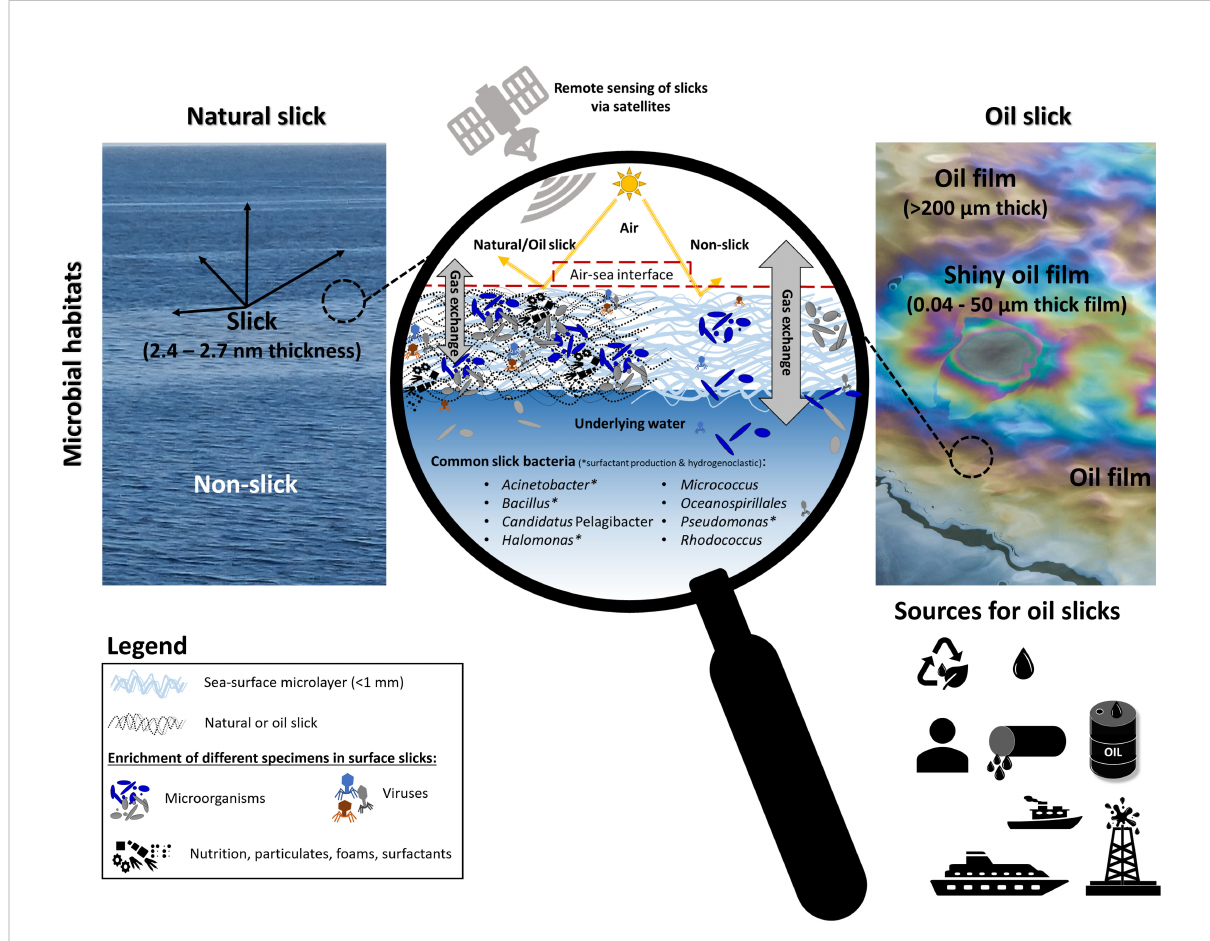
FIGURE 1 Concept of natural surface slicks (left) and oil slicks (right) and associated features. Both slick types interact with important air-sea interface processes compared to adjacent waters, schematized in the magnifying glass (middle). Changes result in increased organic matter content, temperature, viscosity, light re fl ection, and suppressed gas exchange (natural slick only). Particulates, foams, surfactants, and nutrients accumulate in slicks. Sources of oil slicks can have natural (from leakage in sea ground or from onshore leakage: two top symbols) or anthropogenic origin (pipelines, oil platforms, from oil prospects or production, from sea travel or transportation). Remote satellite techniques such as Synthetic Aperture Radar (SAR) imagery can be used to detect slicks from space. The oil slick picture was taken from pixabay.com, license is free for commercial use, no attribution is required. The natural slick photo was taken by one of the